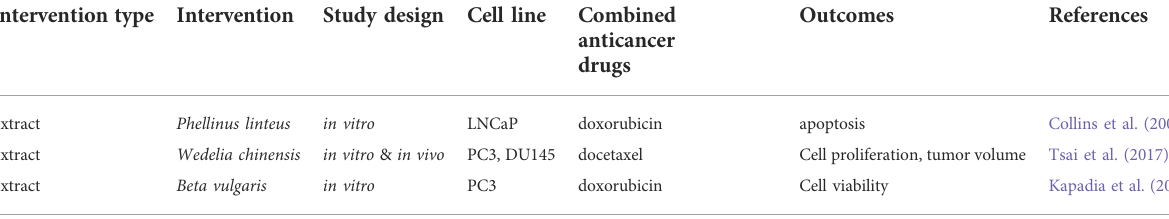
TABLE 3 Summary of studies using whole extraction from a single natural